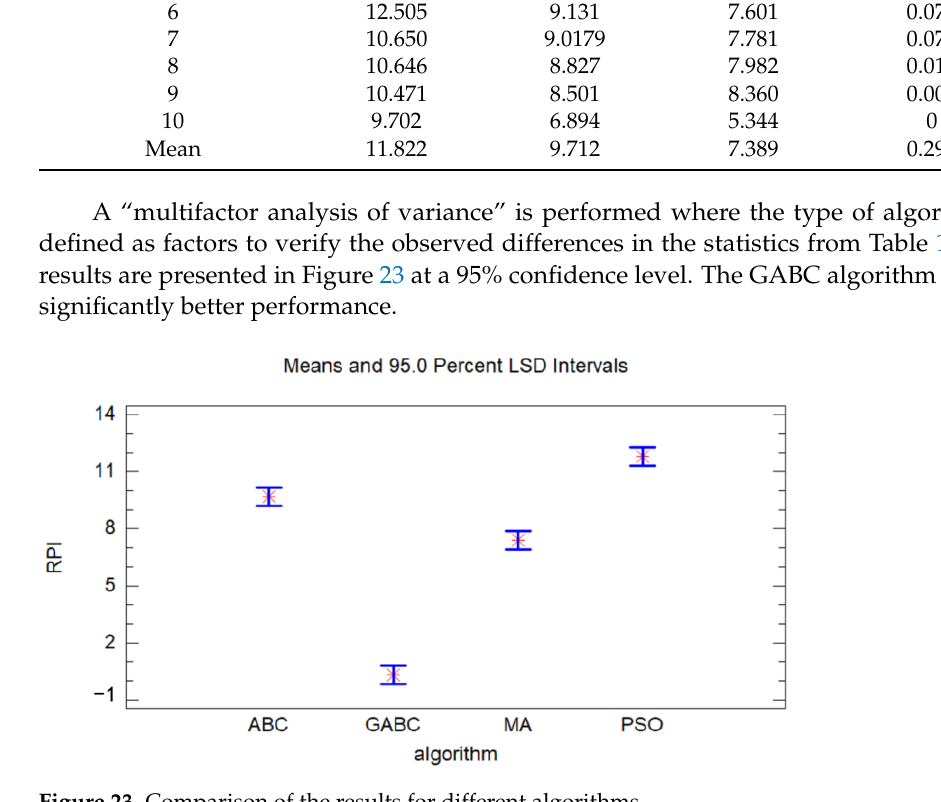
Figure 23. Comparison of the results for different algorithms.